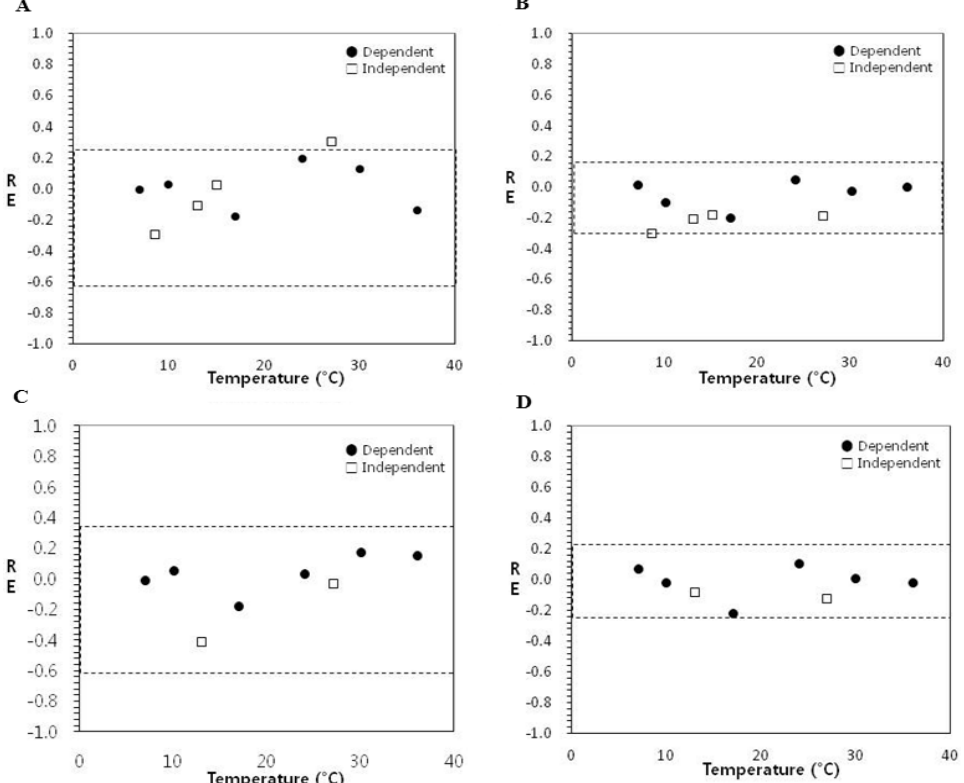
Figure 3. Acceptable prediction zone analysis of the goodness of fit of the secondary model for lag time (LT) and specific growth rate (SGR). RE values are mean (n =